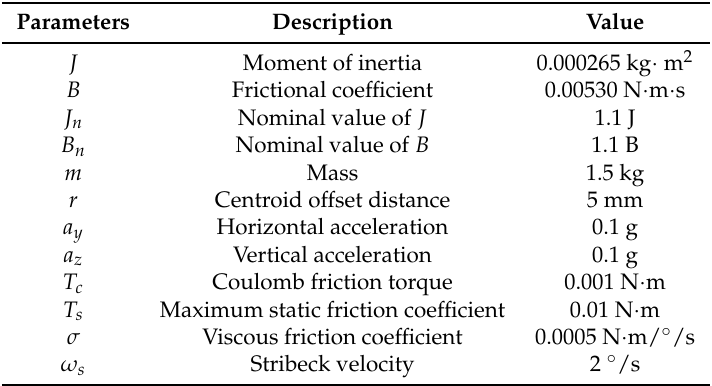
Table 1. Simulation parameters of the ISIS system.